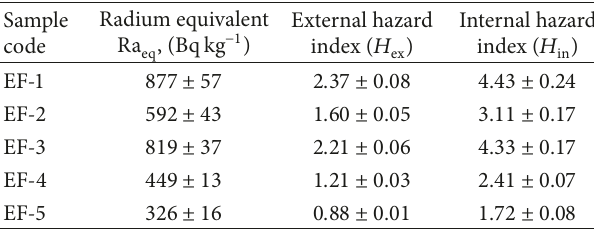
Table 3: The Radium equivalent and hazard index in Egyptian